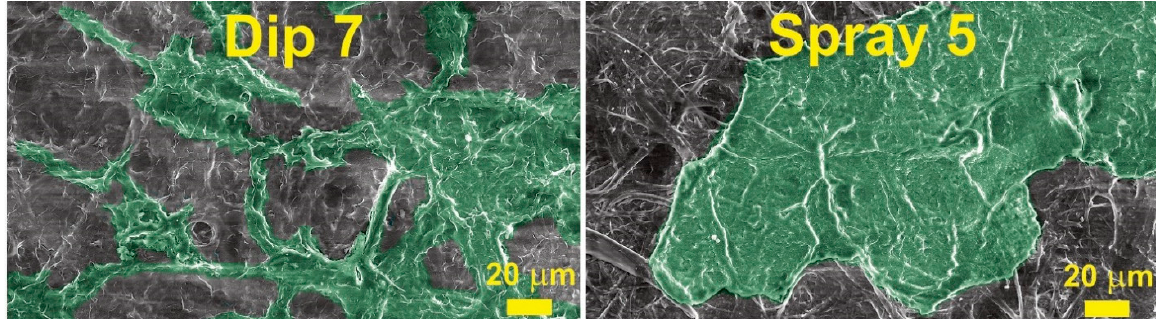
Figure 7. SEM micrographs with highlighted (green) wax agglomerates. The wax was applied with 1.0 wt.% solution. 1.0 wt.%